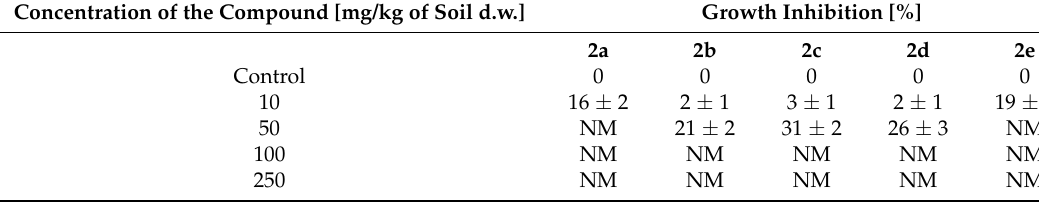
Growth inhibition (%) of Heterocypris incongruens living in soil contaminated with aminophosphonates 2a – e at concentrations of 10, 50, 100, and 250 mg/kg of soil dry weight. SD means standard deviation (SD, n = 6 determinations). NM means not measured because mortality was higher than